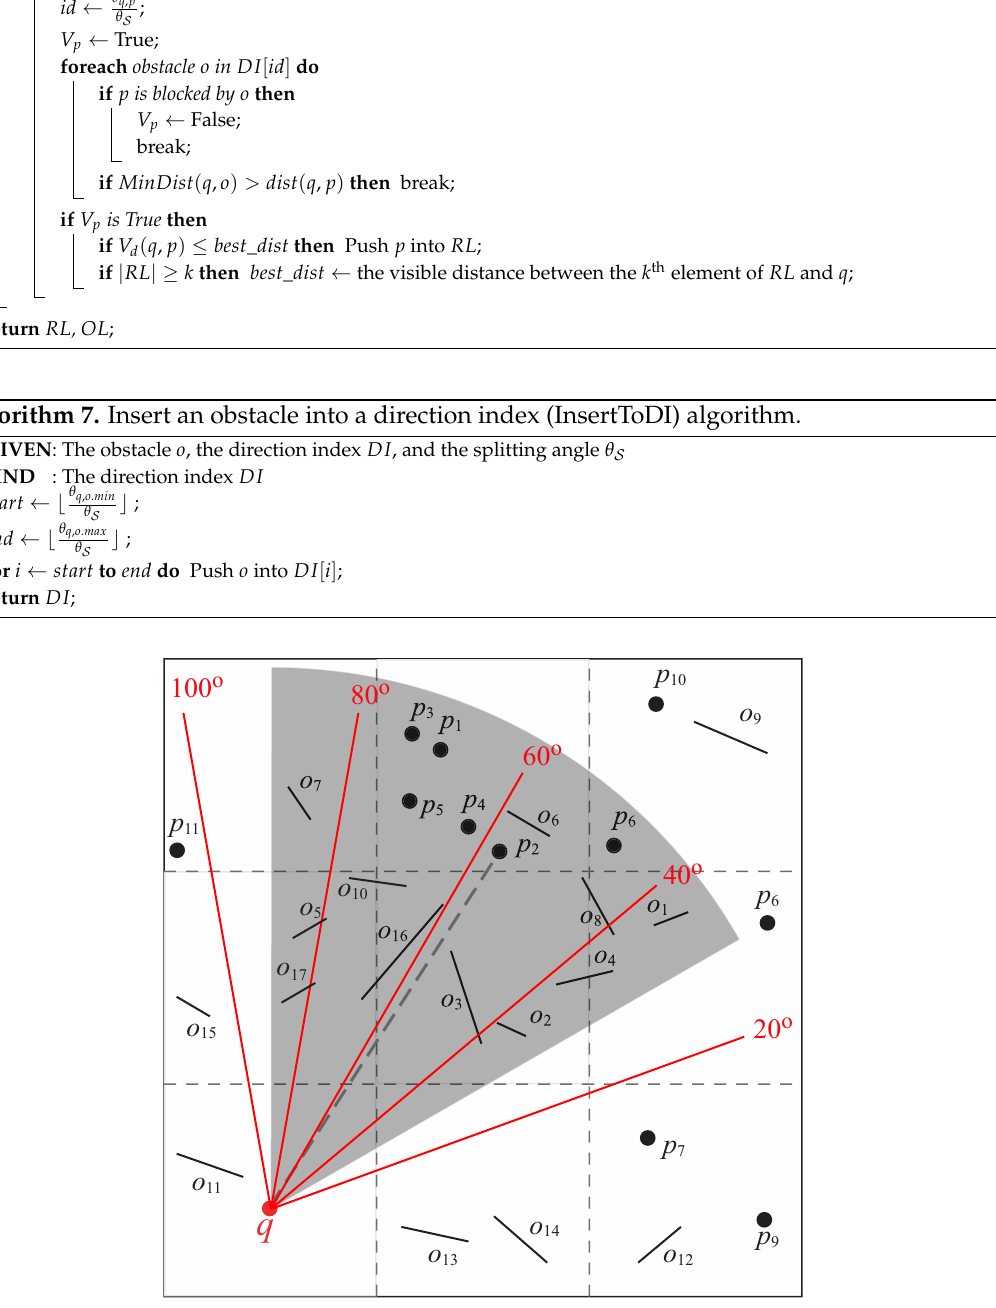
Figure 20. An example of the direction index ( θ S = 20 ◦ )